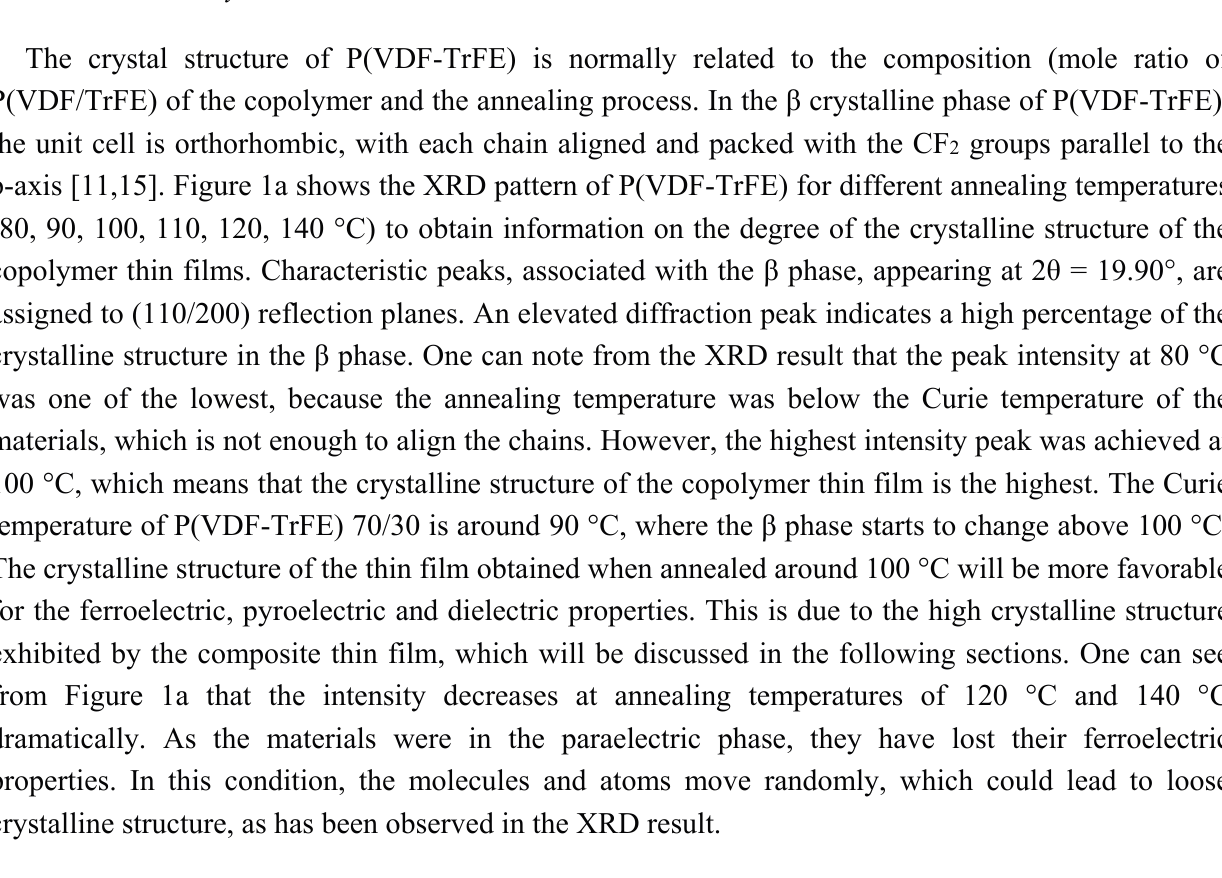
Figure 1. ( a ) XRD result of poly(vinylidene fluoride-trifluoroethylene) (P(VDF-TrFE)) thin films of different annealing temperatures (80, 90, 100, 110, 120, 140